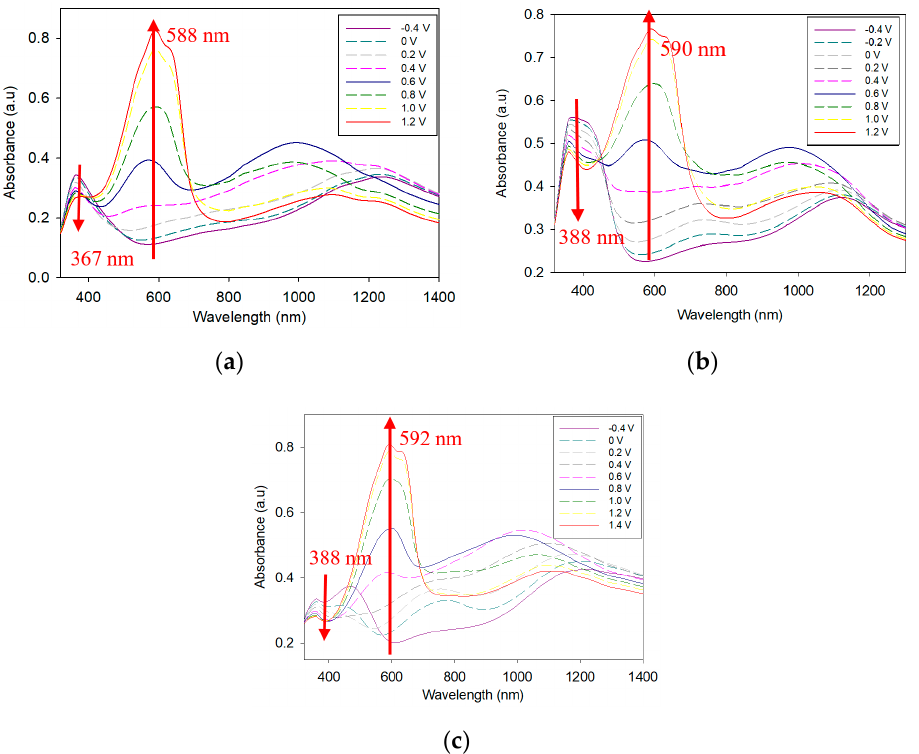
Figure 8. UV plots of: ( a ) PTTPP/PProDOT ‐ Et 2 ; ( b ) P(TTPP ‐ co ‐ DTC)/PProDOT ‐ Et 2 ; and ( c ) P(TTPP ‐ co ‐ DTP)/PProDOT ‐ Et 2 ECDs at various voltages.